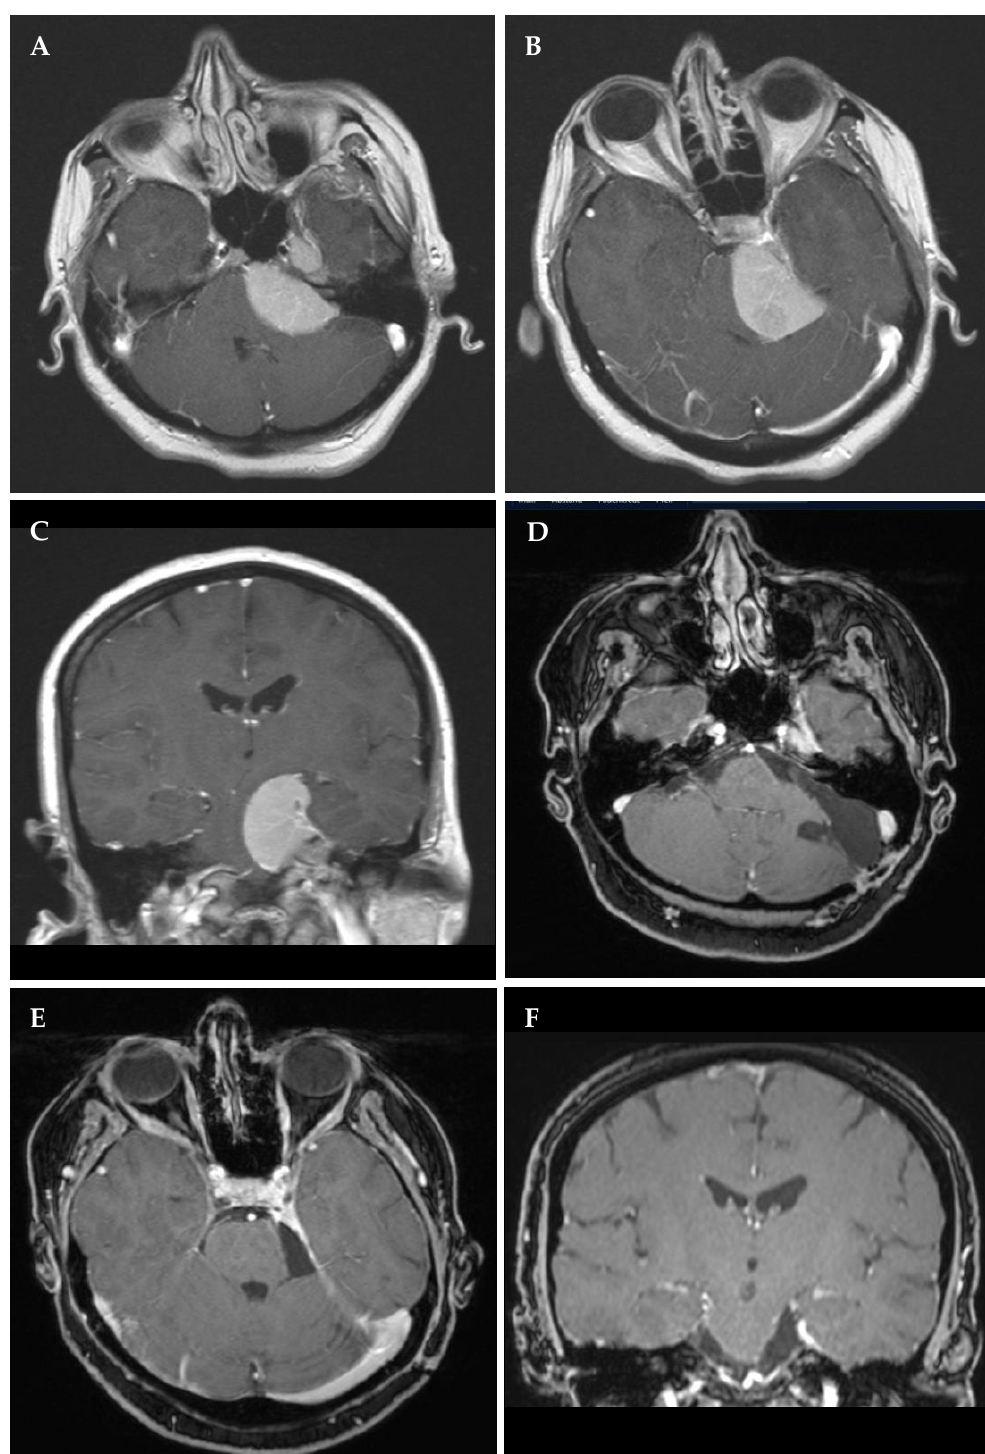
Figure 2. Left petroclival meningioma in a 48-year-old female with headaches and intermittent dysphagia. Preoperative contrast-enhanced T1 magnetic resonance imaging (MRI) in axial ( A , B ) and coronal I ( C ) reconstructions with compression of the brain stem but without invasion of the cavernous sinus. Most of the lesion was situated in the infratentorial compartment and was reached by a retrosigmoid approach, with only minor residual tumor appreciated in Meckel’s cave ( D – F ). Six years later, the patient underwent radiation therapy (54 Gy) for tumor progression, while she remained without deficits throughout follow-up.